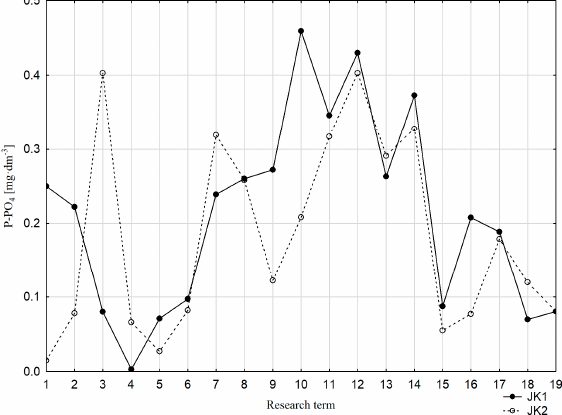
Figure 5. Orthophosphate content at sampling points in Lake Kórnickie.